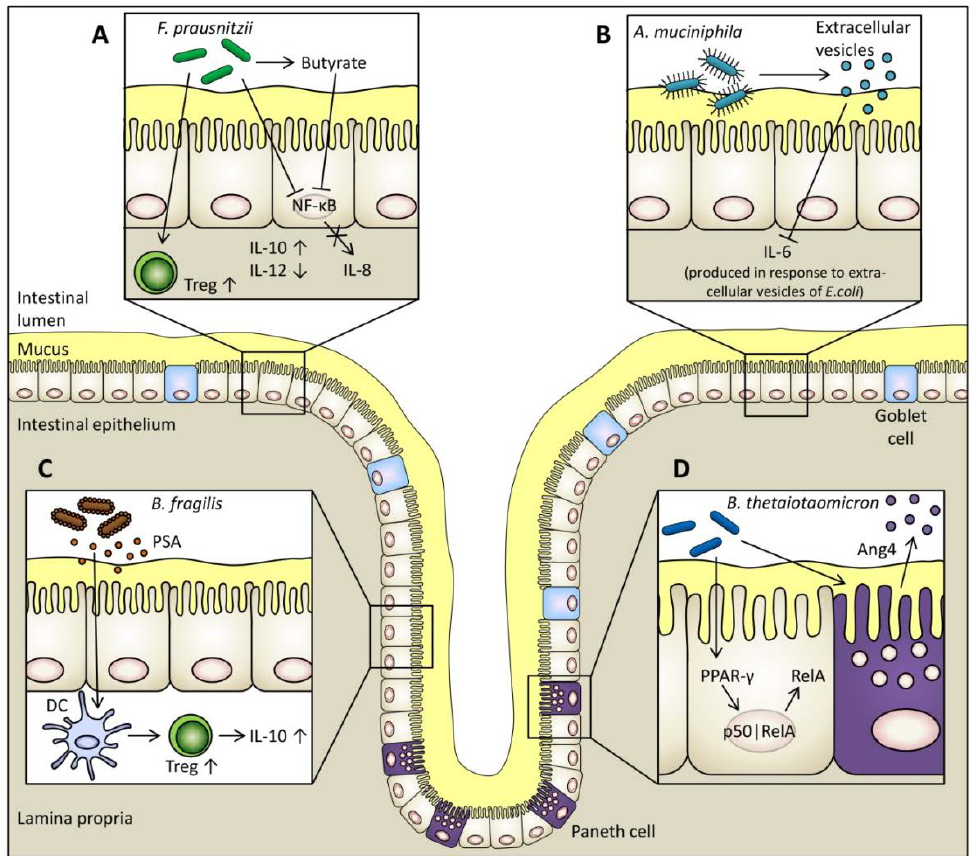
Figure 1. Proposed immunomodulatory mechanisms of four examples of obligate anaerobic commensals. ( A ) The supernatant of F. prausnitzii blocks the activation of